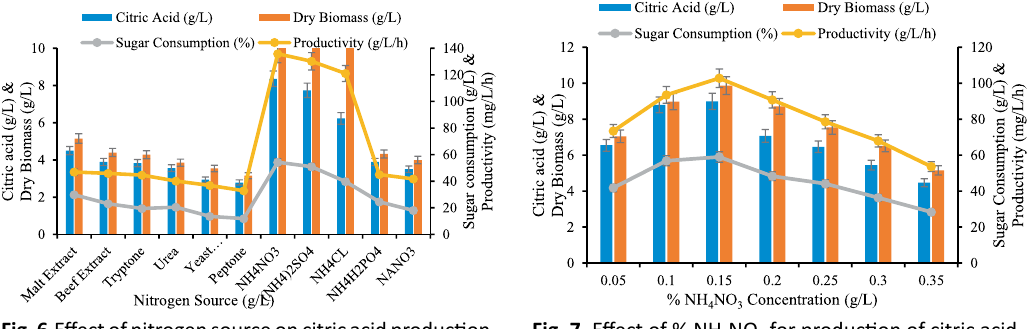
Fig. 6. Effect of nitrogen source on citric acid production. Fig. 7. Effect of % NH